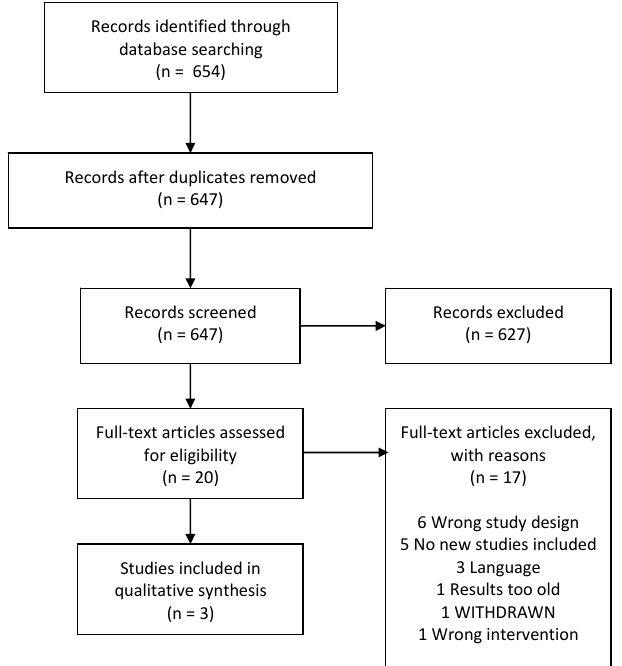
Figure 1. Flowchart of the systematic reviews.